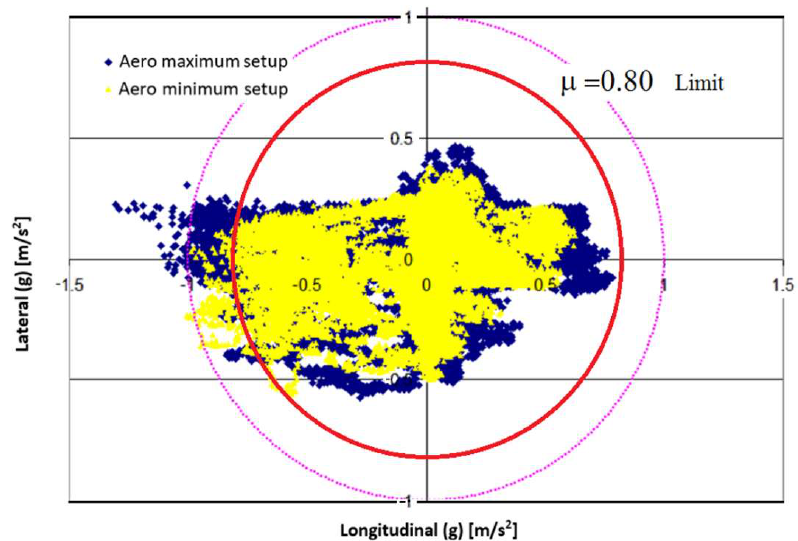
Figure 34. Parameters of the vehicle registered for minimum and maximum aerodynamic setup (MA). Steering wheel angle, yaw angle, and velocity are presented for described maneuvers. Lon- gitudinal velocity is multiplied by 10.